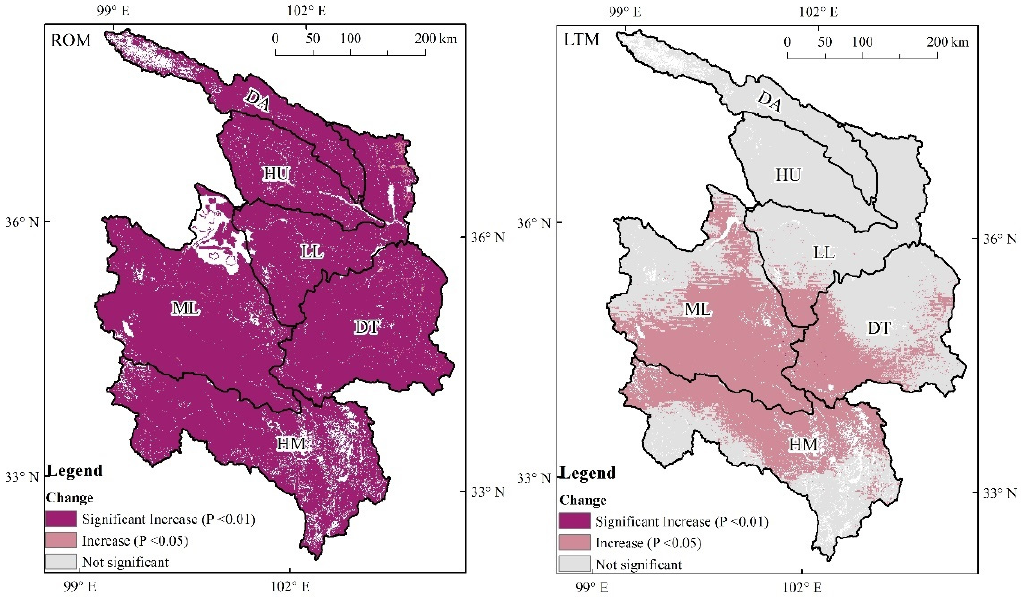
Figure 6. Spatial distribution of runoff depth change calculated by two methods.